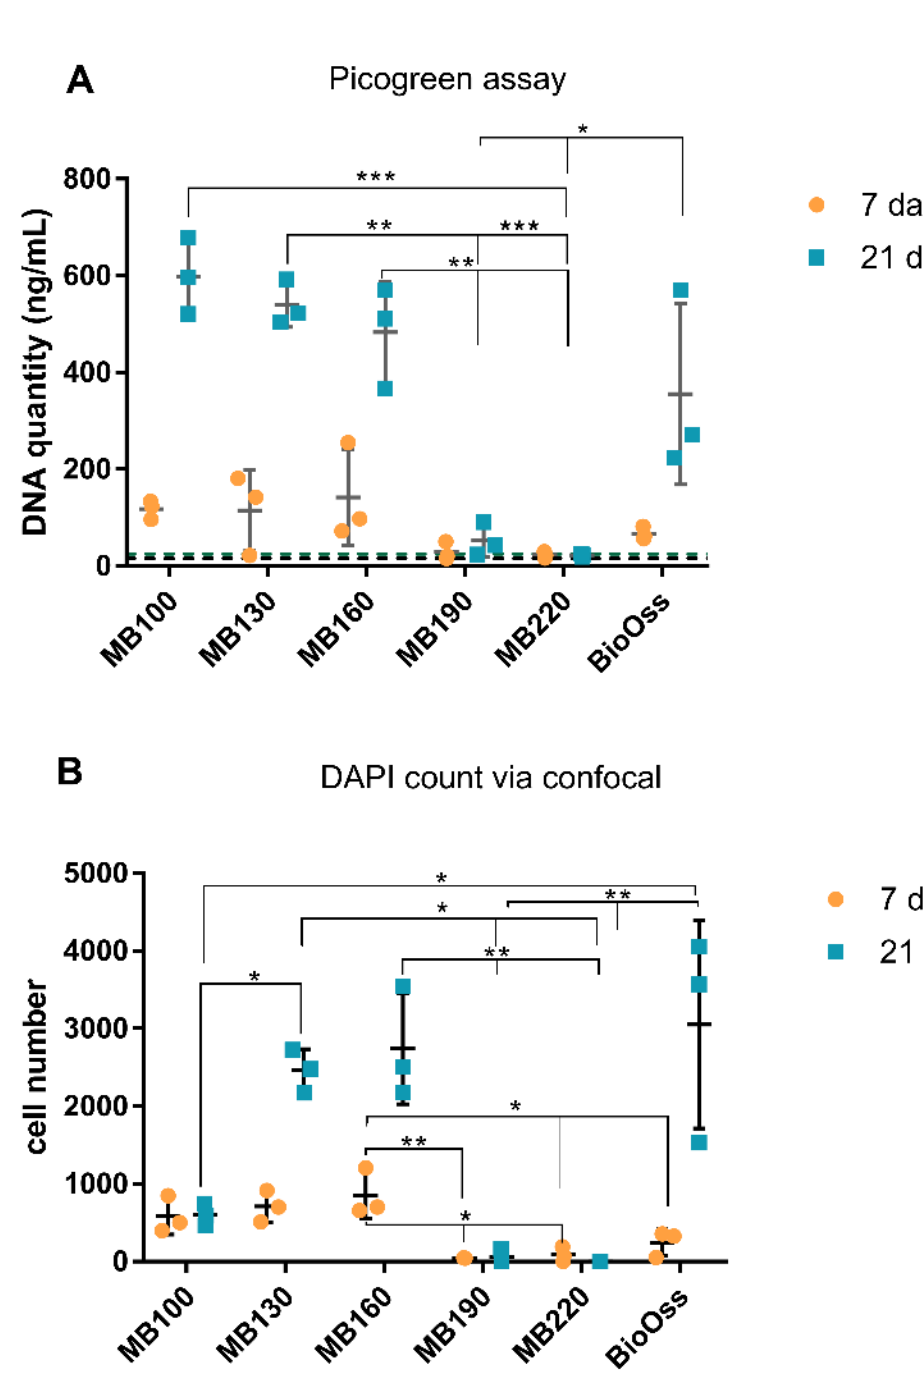
Figure 3. Osteoblast quantities at 7 and 21 days on bone scaffold specimens using picogreen assay ( A ), and cell counting of DAPI stained nuclei using confocal laser scanning microscopy and Fiji:image J analysis ( B ). N = 3. Results expressed as mean ± SD. Dotted lines: 7-day negative control (black) and 21-day negative control. Significant values * p ≤ 0.05, ** p ≤ 0.01, *** p ≤ 0.001.